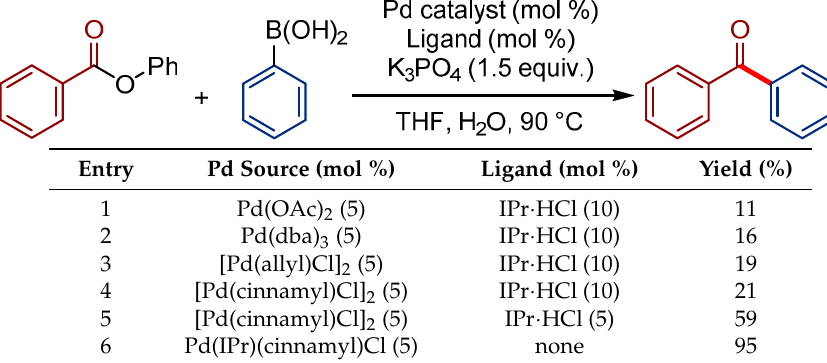
Table 1. Optimization study for the Suzuki-Miyaura cross-coupling of aryl esters.